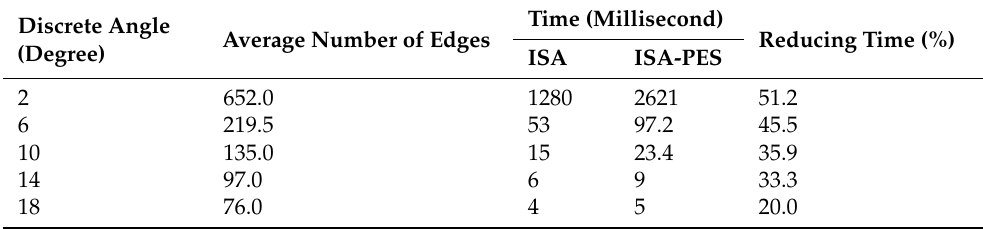
Table 2. The creation time for the Arc1